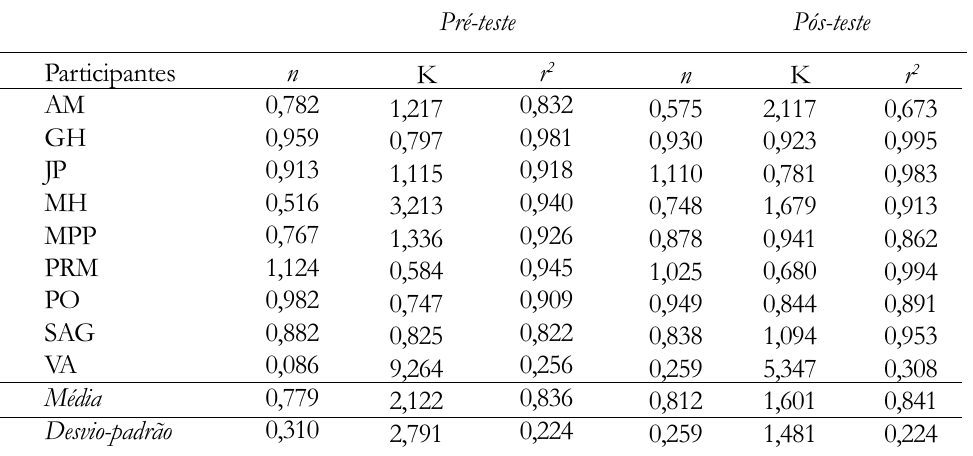
Psicologia: Reflexªo e Cr(cid:237)tica, 2004,